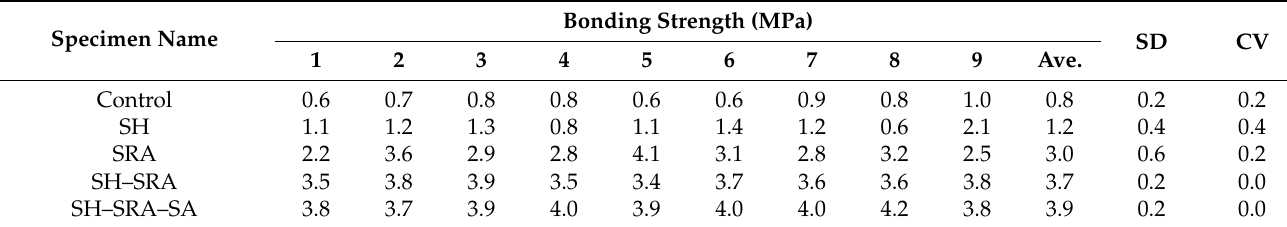
Table 5. Results of bonding